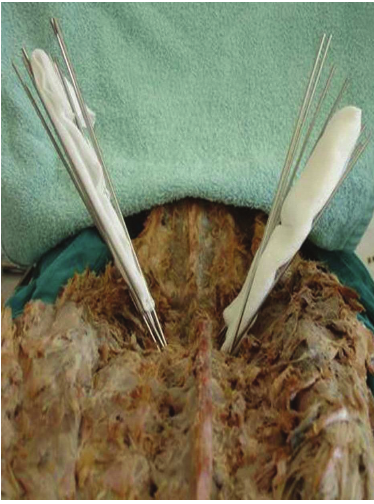
Figure 1: All wires in place. There is a gauze sponge between the 10-degree wires on the right and the 15-degree wires on the left.